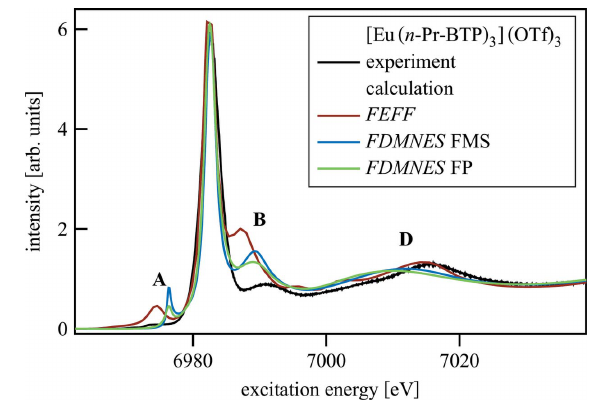
Figure 3 Gd L 3 -edge HR-XANES of [Gd( n -Pr-BTP) 3 ](OTf) 3 measured at the Gd L (cid:2) 1 and L (cid:3) 2 emission line.